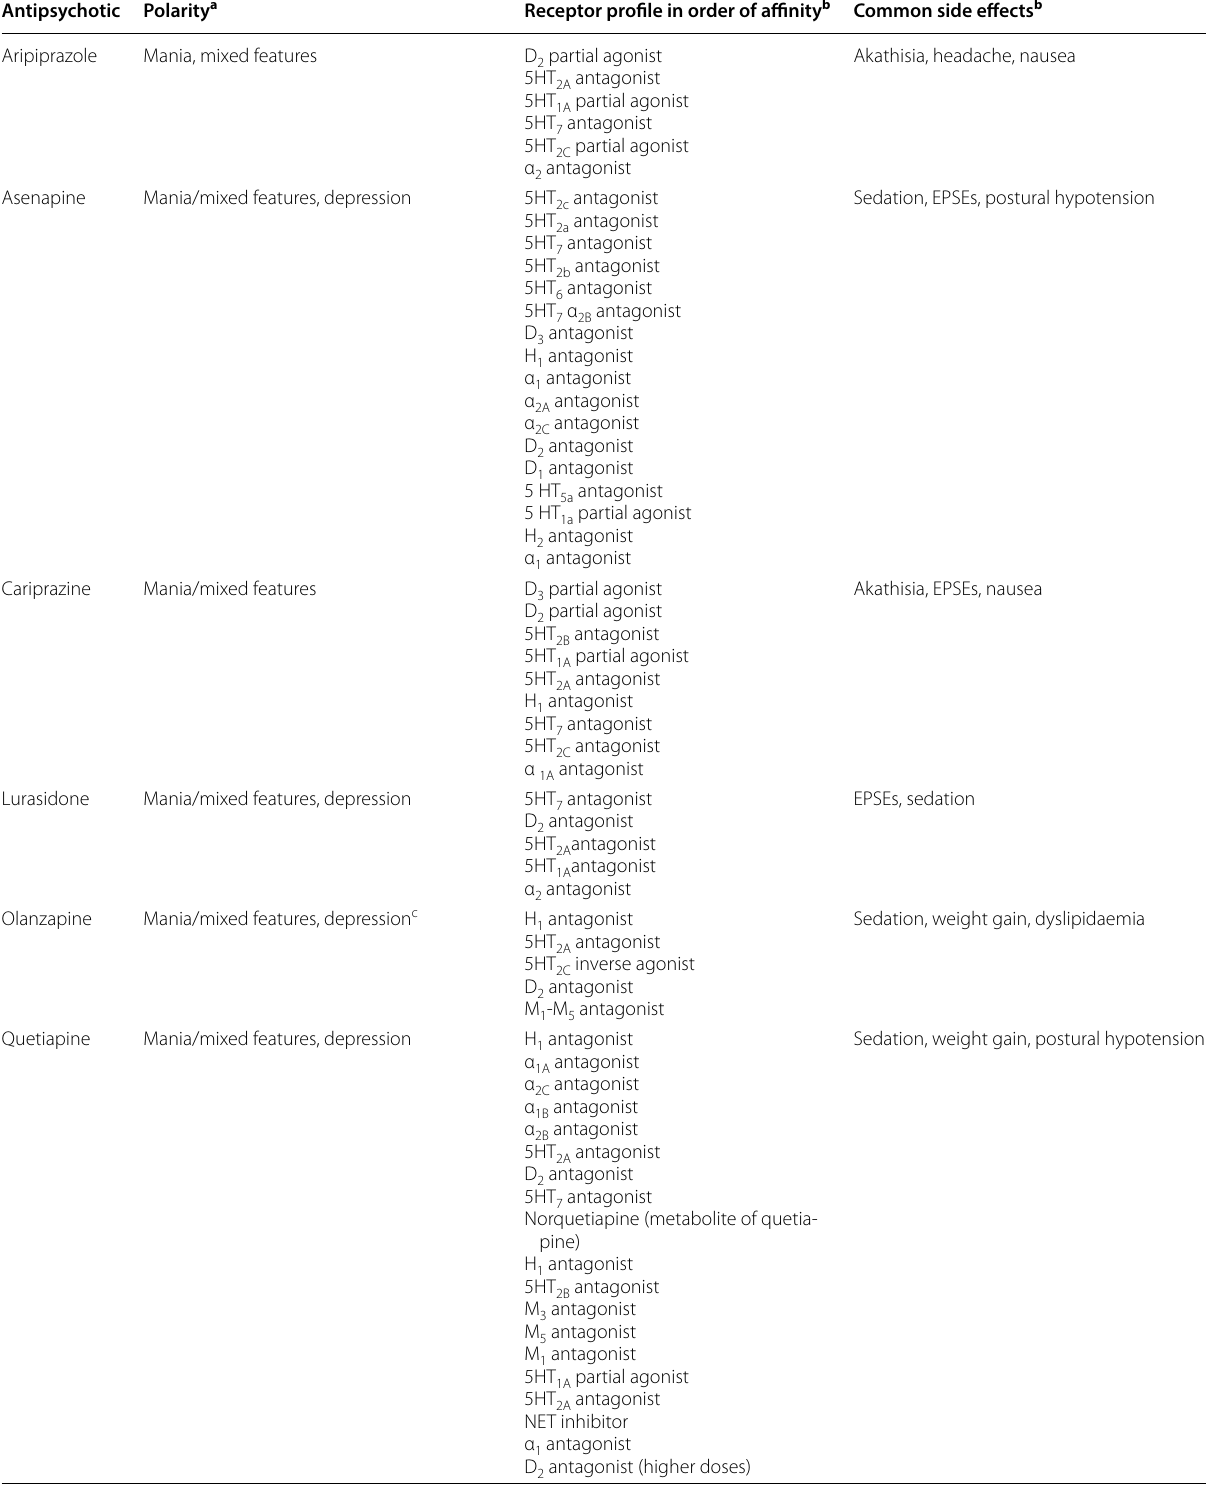
Table 1 Polarity, receptor affinities and side‑effects of antipsychotics used in the maintenance treatment of bipolar